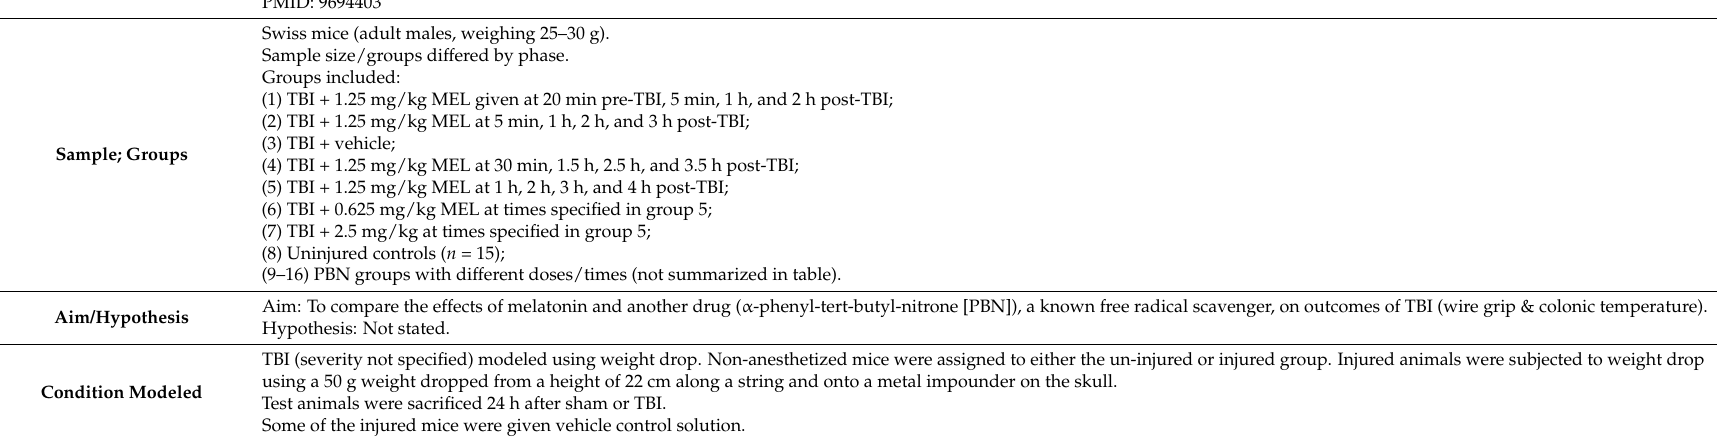
Table A1. M é senge et al. (1998) Study